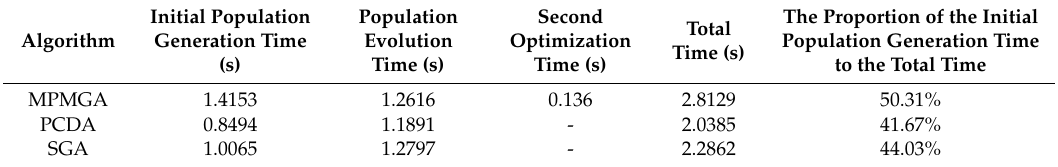
Table 3. Comparison table of the running time of each segment program of the three algorithms.